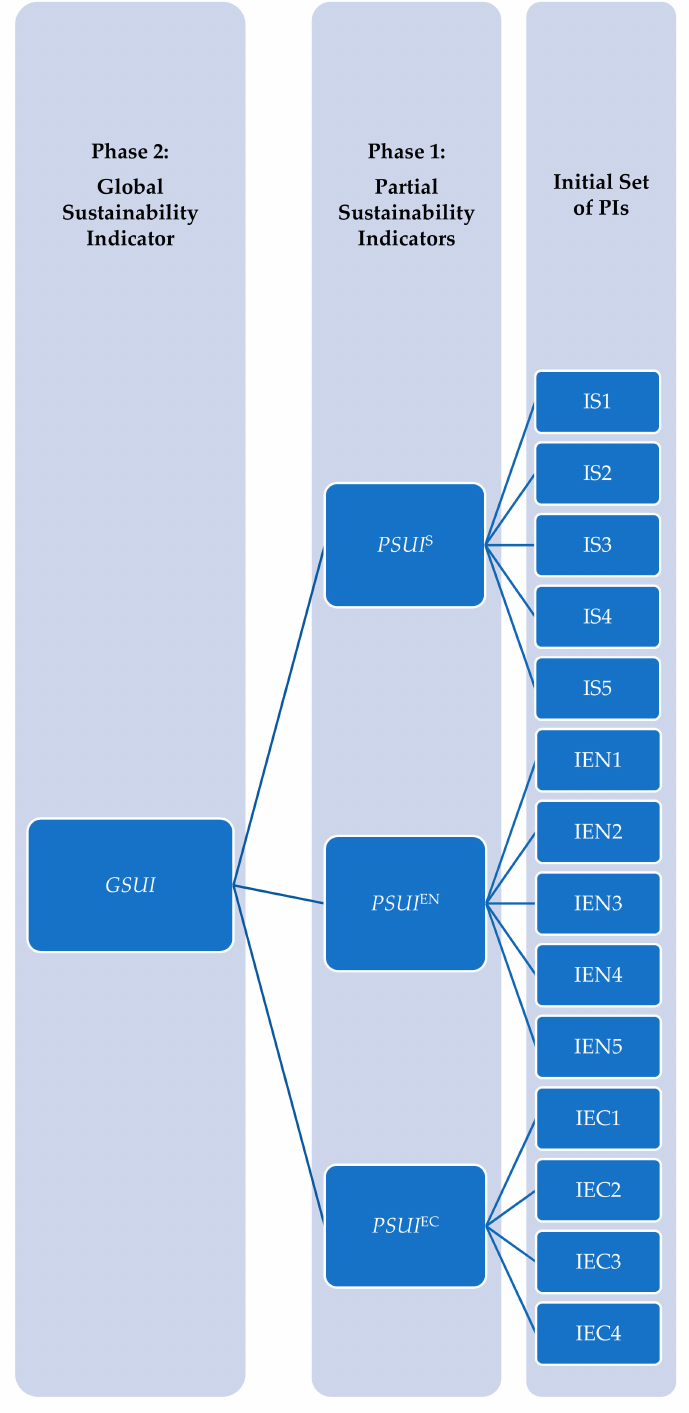
Figure 2. The two-phase approach applied to the case